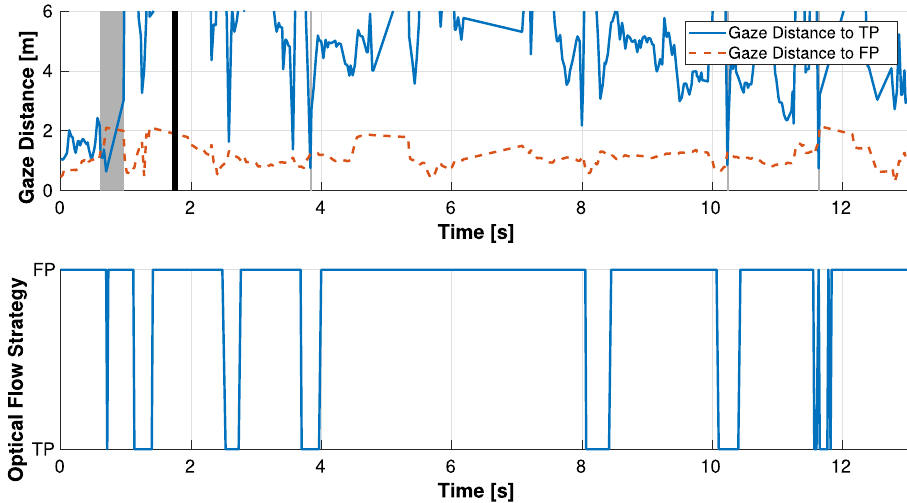
Figure 12. Result in curved situation. The top figure shows the gaze distance to TP/FP of the observed driver behavior. The gray zone means TP fixation strategy, while the black line is the boundary between the straight and curved sections. The bottom figure shows the calculated gaze strategy based on optical flow theory. The result estimates either FP or TP fixation behavior.